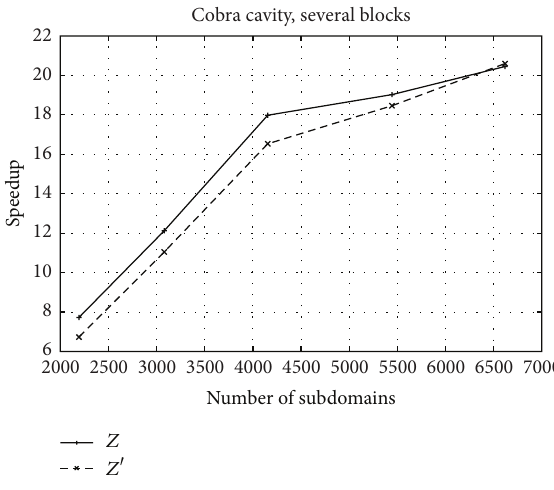
Figure 12: Speedup when dividing the cobra cavity geometry in several